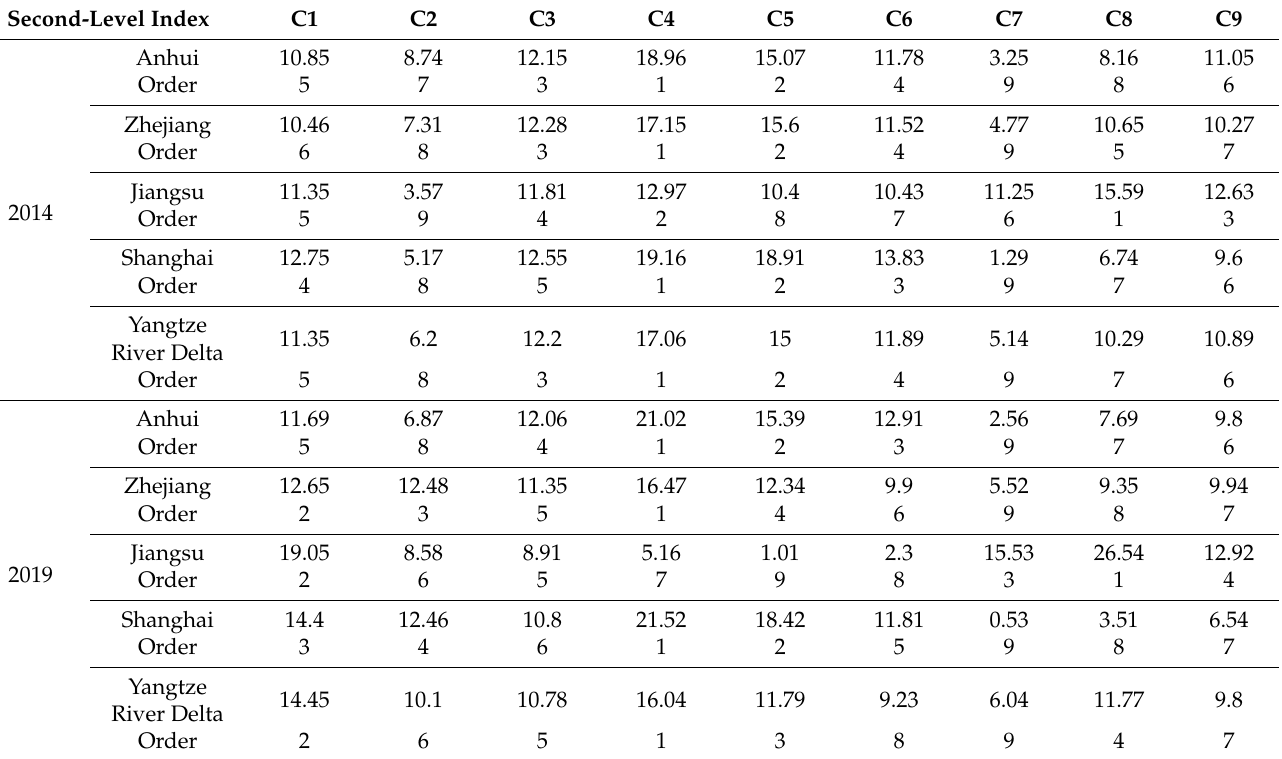
Figure 7. Obstacle degree of the subsystem of the innovation EROB complex system in the YRD. Table 7. Obstacle scores and ranking of the primary indices in the